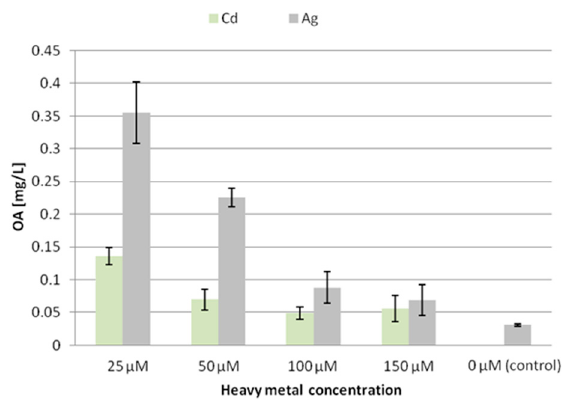
Figure 2. The content of oleanolic acid in hairy root tissue (CC16 line) after elicitation with silver and cadmium ions. OA—oleanolic acid.